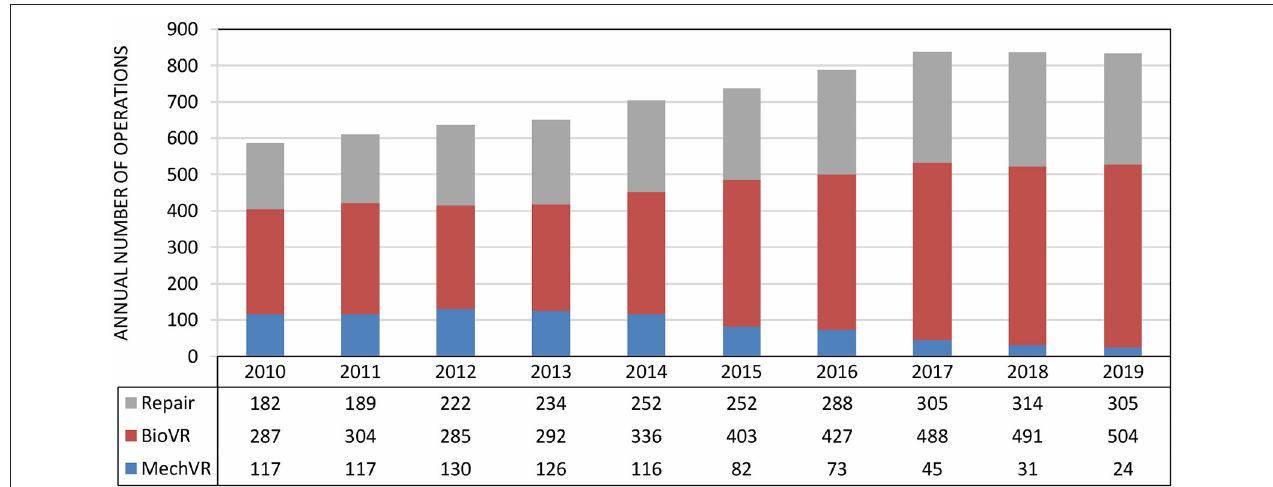
FIGURE 1 | Evolution of surgical valve repair and replacement at the University Hospitals Leuven from 2010 to 2019. The annual numbers include data from all four heart valve positions. From 2010 to 2019, there has been a steady increase in the annual number of surgical valve repairs and bioprosthetic valve replacements, but a decrease in the annual number of mechanical valve implantations. BioVR, biological valve replacement (including Ross procedure); MechVR, mechanical valve replacement.